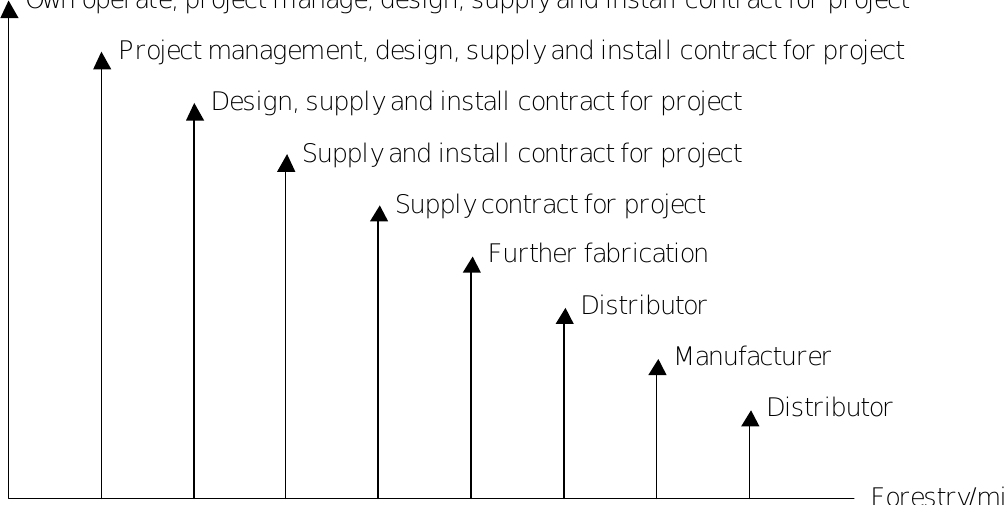
Figure 2: Supply-chain value-adding possibilities for manufacturers in the B&C